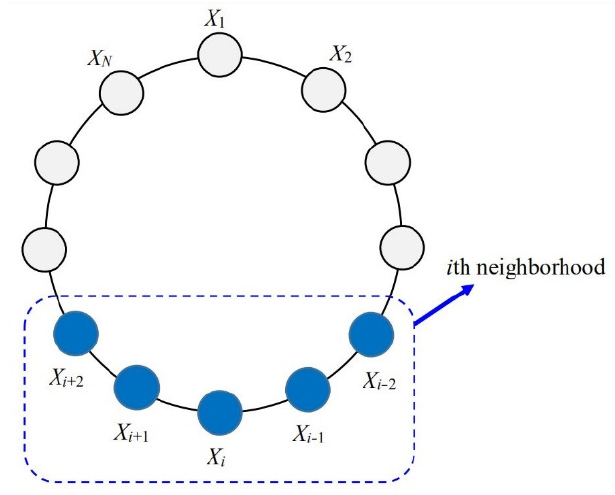
Figure 3. Ring topology of i th-neighborhood in BSONME.